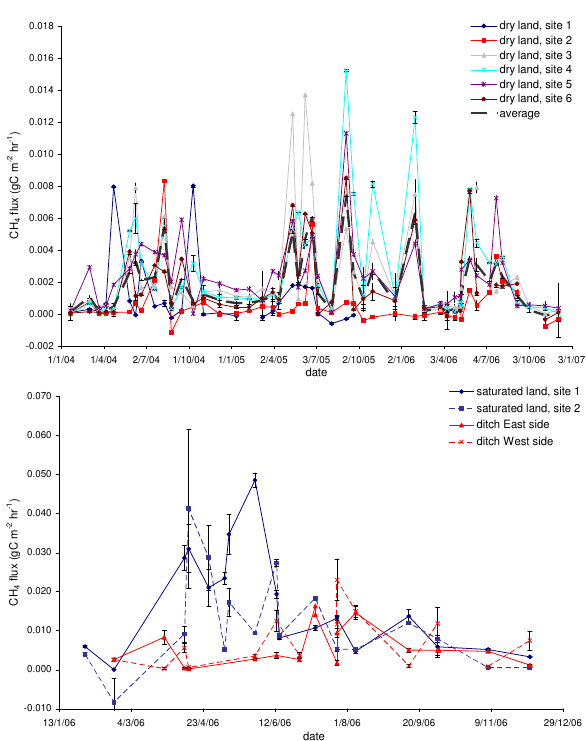
Fig. 5. Daily NEE, GEP, R eco and cumulative NEE over the year for 2004 (upper graph), 2005 (middle graph) and 2006 (bottom graph). Ditches: